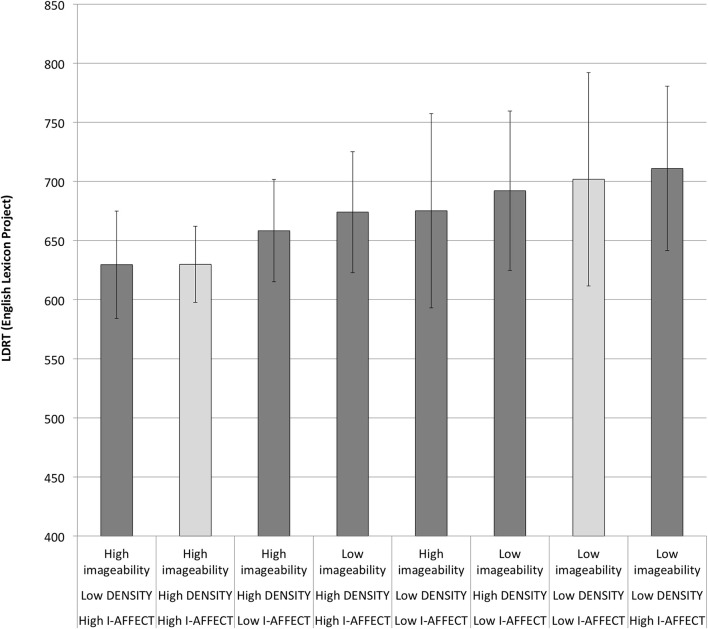
LDRTs from the English Lexicon Project. Light gray bars are the extreme cases, words that are all high or all low on imageability, DENSITY, and I-AFFECT. See also Figure 3.